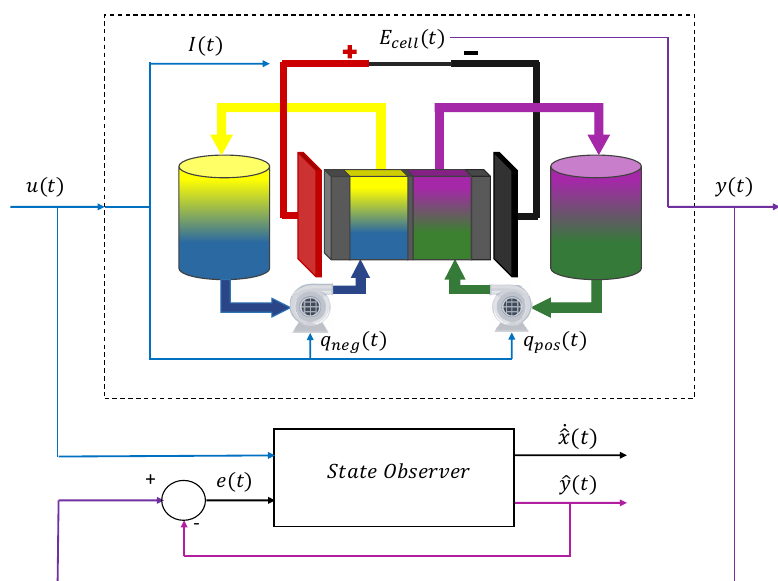
Figure 6. General scheme of a state observer for a